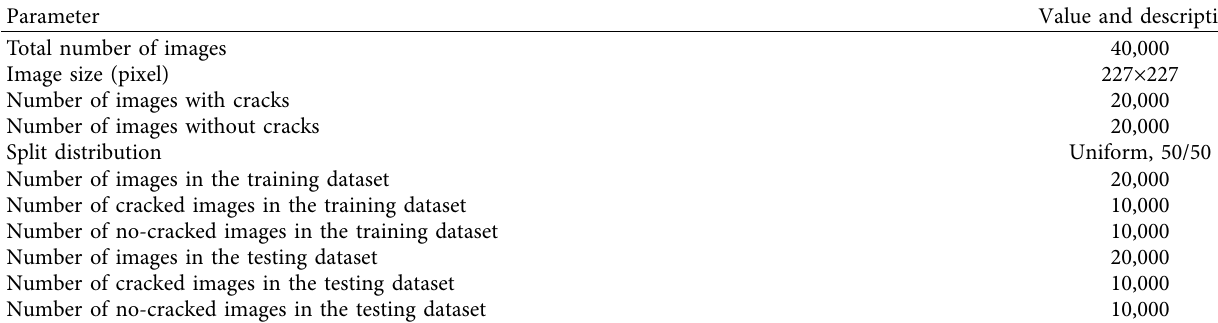
Figure 1: Examples of the images without and with cracks in the database. Different types of surface finishes and illumination conditions are observed. Table 1: Summary information of the